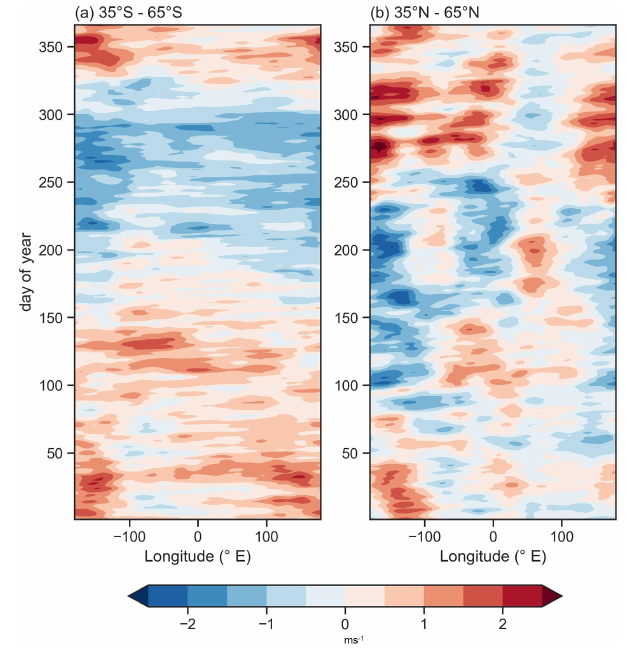
Figure A1. R anomalies for the Southern and Northern Hemi- sphere. Anomalies for the day-of-year mean are calculated with re- spect to mean R fields.